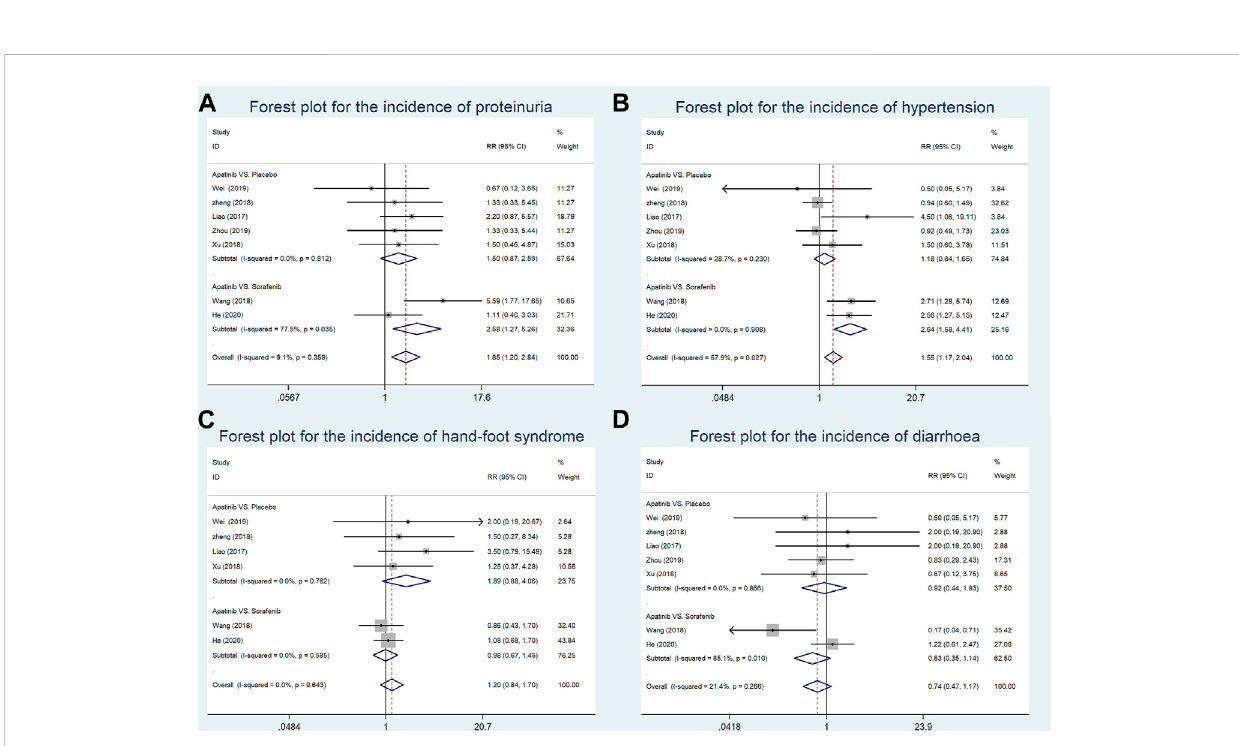
FIGURE 6 Forest plots for the incidence of adverse events in included studies in the fi rst-line setting. (A) Meta-analysis for incidence of proteinuria; (B) meta- analysis for incidence of hypertension; (C) meta-analysis for incidence of hand – foot syndrome; (D) meta-analysis for incidence of diarrhea. RR indicates the ratio of the incidence of each outcome; 95% con fi dence interval is presented as error